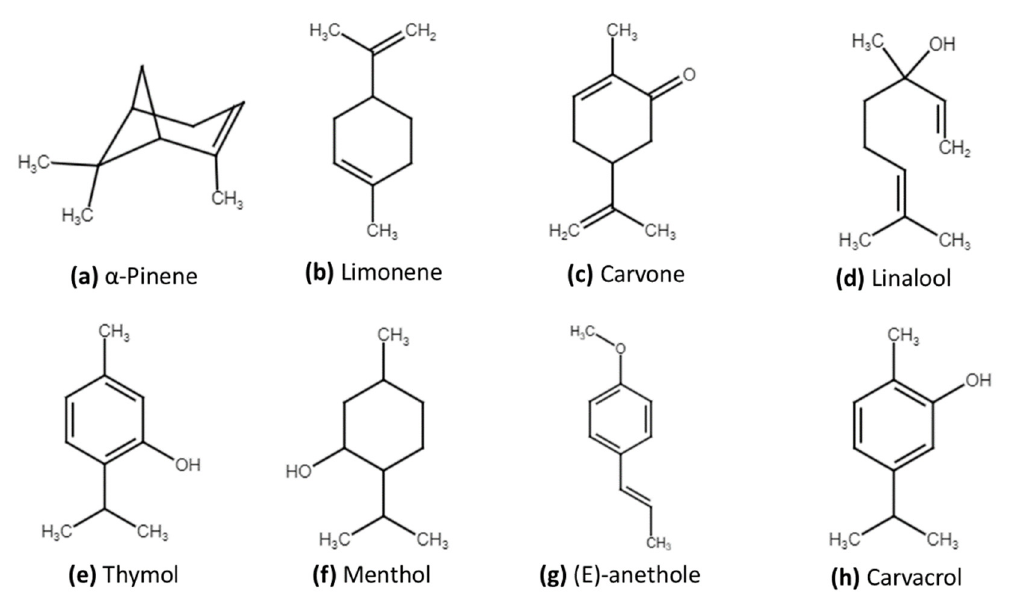
Figure 1. Chemical structure of several major components with potential biocidal activity;